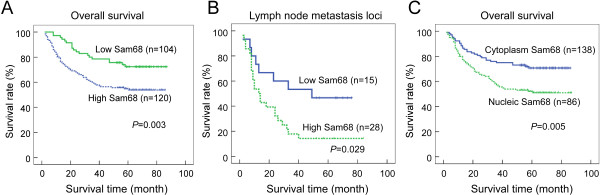
Influence of Sam68 expression on overall survival in colorectal cancer (CRC). (A) Kaplan–Meier curves showing that patients with high Sam68 expression had poorer overall survival than patients with low Sam68 expression; analysis of 224 primary CRC tissues (P = 0.003). (B) Kaplan–Meier curves showing that patients with high Sam68 expression in metastatic lymph node tissues had poorer overall survival than patients with low Sam68; analysis of 43 metastatic lymph node tissues (P = 0.029). (C) Kaplan–Meier curves showing that patients with nuclear Sam68 expression had poorer overall survival than patients with cytoplasmic Sam68 expression; analysis of 224 primary CRC tissues (P = 0.005).